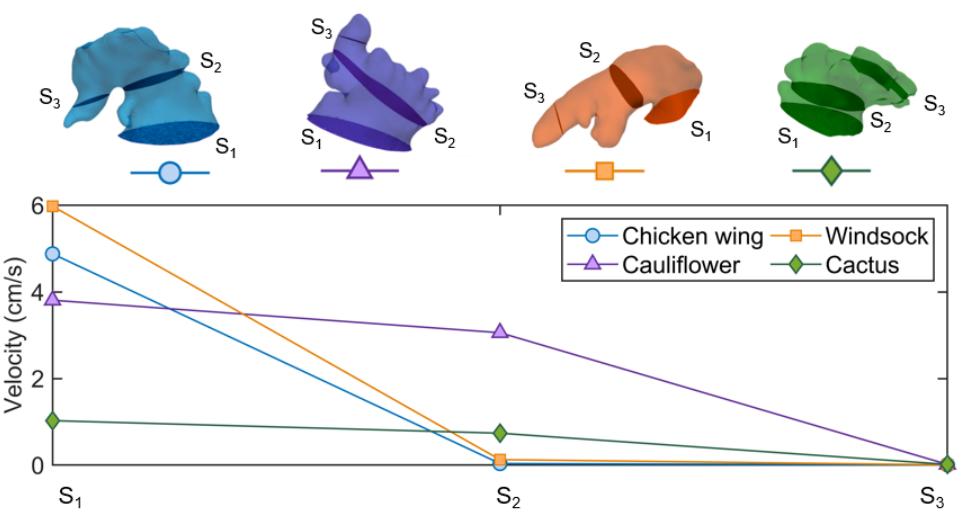
Figure 9. Flow velocity at three different planes: ostium section ( S 1 ), mid section ( S 2 ) and distal tip section ( S 3